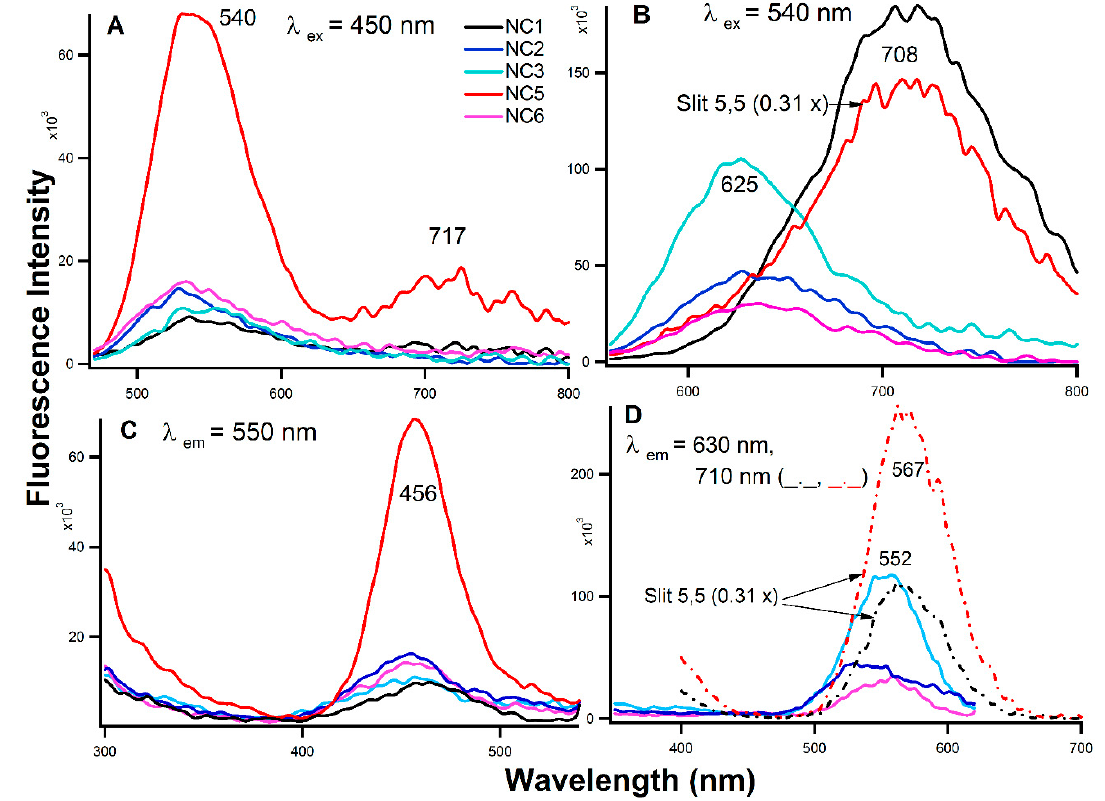
Figure 2. Fluorescence emission (A, B) and excitation (C, D) spectra of the aptamer-templated silver nanoclusters in water. [DNA] = 15 µM, [AgNO 3 ] = 90 µM, and [NaBH 4 ] = 90 µM. Excitation and nanoclusters in water. [DNA]